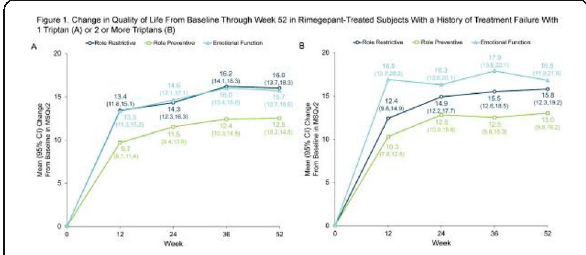
Fig. 1 (abstract P0272). See text for